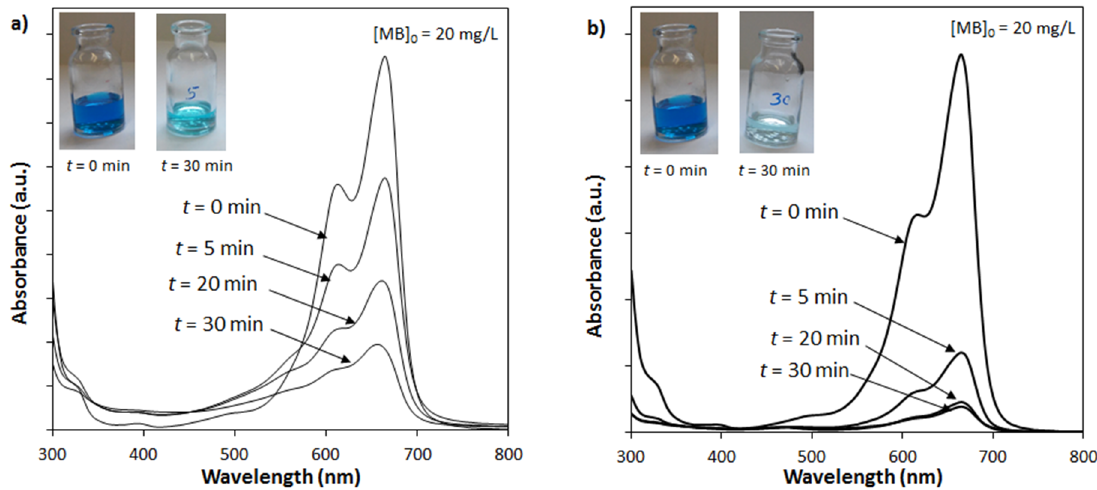
Figure 6. Ultraviolet-visible (UV/Vis) spectra of methylene blue dye (MB) aqueous solutions at different times for a 0.2 g of ( a ) SrCO 3 ‐ Sr(OH) 2 ; and ( b ) SrCO 3 ‐ Sr(OH) 2 /PPy nanocomposites.